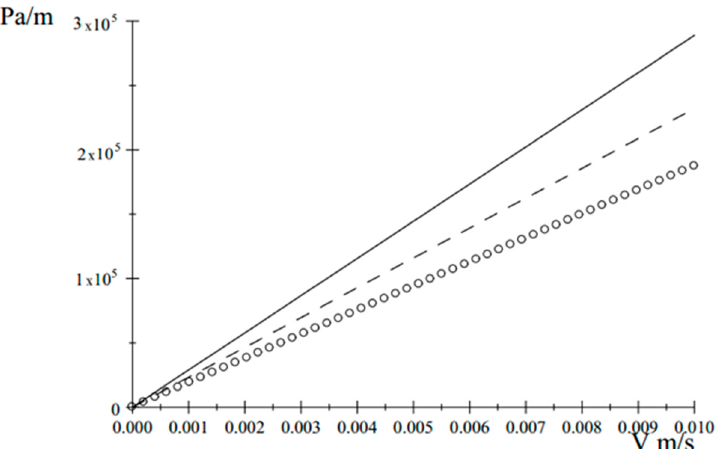
Figure 7. Bed porosity effect with d p = 0.01 m, ϕ = 0.1, and ε = 0.38 (solid line), 0.4 (dashed line), 0.42 (dotted line).